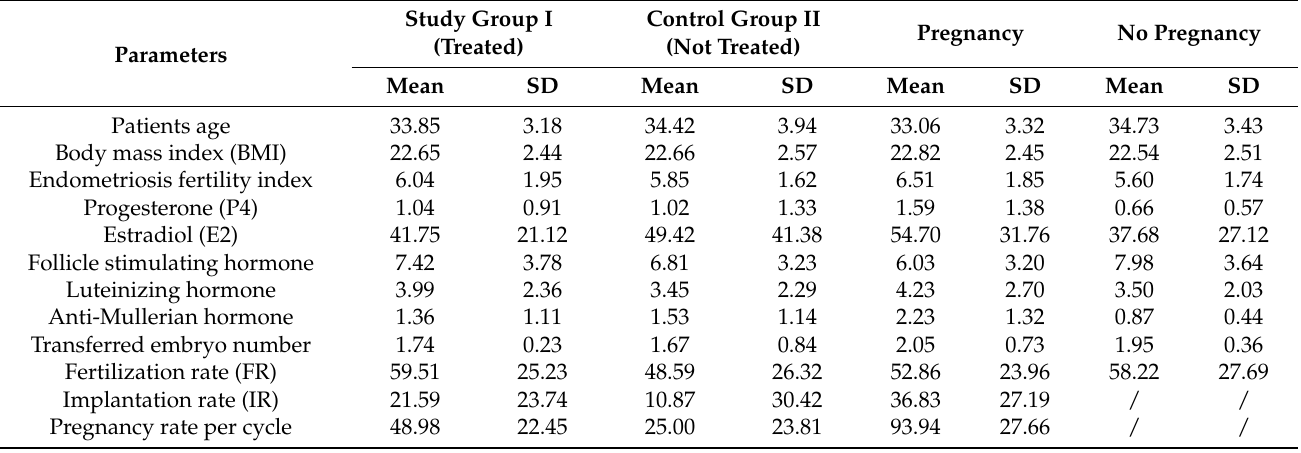
Table 1. Descriptive parameters of the investigated endometriosis patients according to the examined groups.